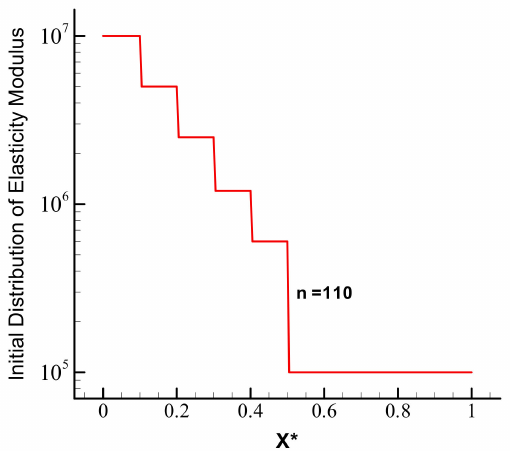
Figure 23. Initial distribution of the elastic modulus along the blade suction side in the third design case by UESA, X*—coordinate.